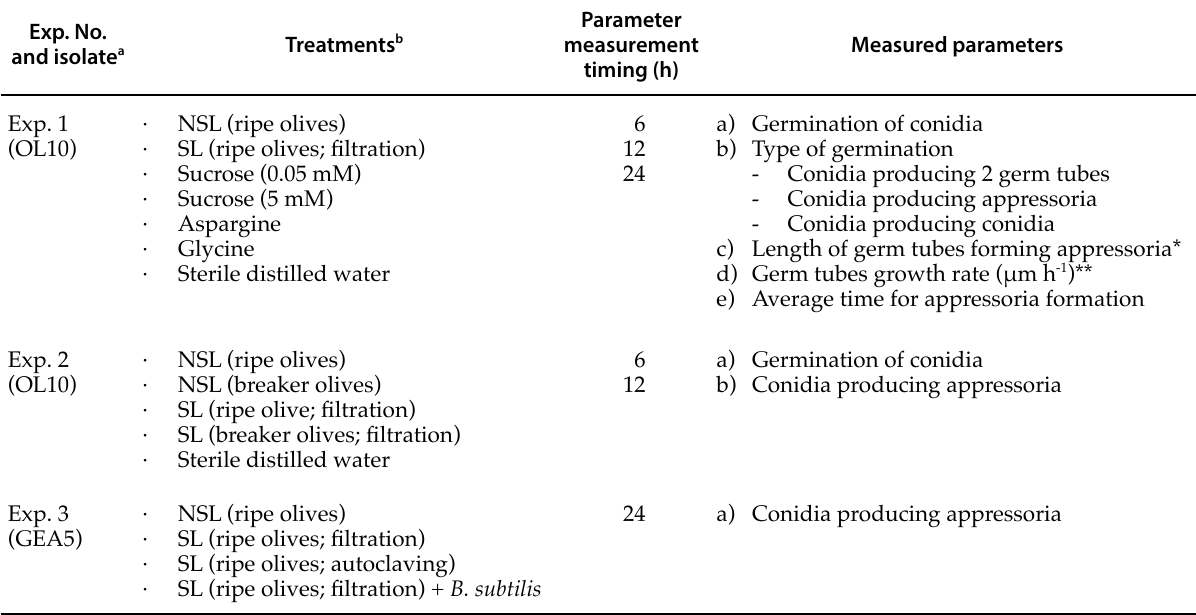
Table 1. Summary of the trials conducted to evaluate the effects of non-sterile (NSL) and sterile (SL) olive leachates on conidium germination of different isolates of Colletotrichum godetiae . The effects of three exogenous nutrients (sucrose, aspargine and glycine) and the addition of Bacillus subtilis cells to sterile olive leachates were also investigated. Exp. No. and isolate